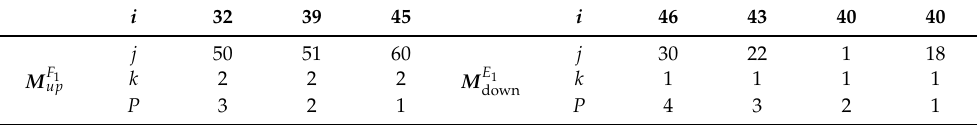
Table 11. Scheduling tasks of Elevator-EF in the second half cycle i 32 39 45 i 46 43 40 40 j 50 51 60 j 30 22 1